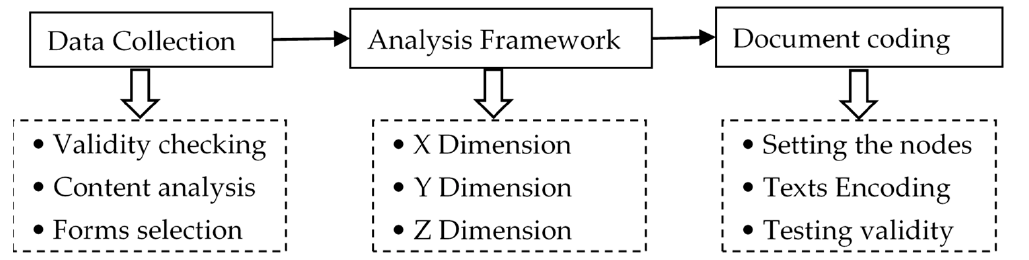
Figure 2. The analysis process for integrated care policy documents.